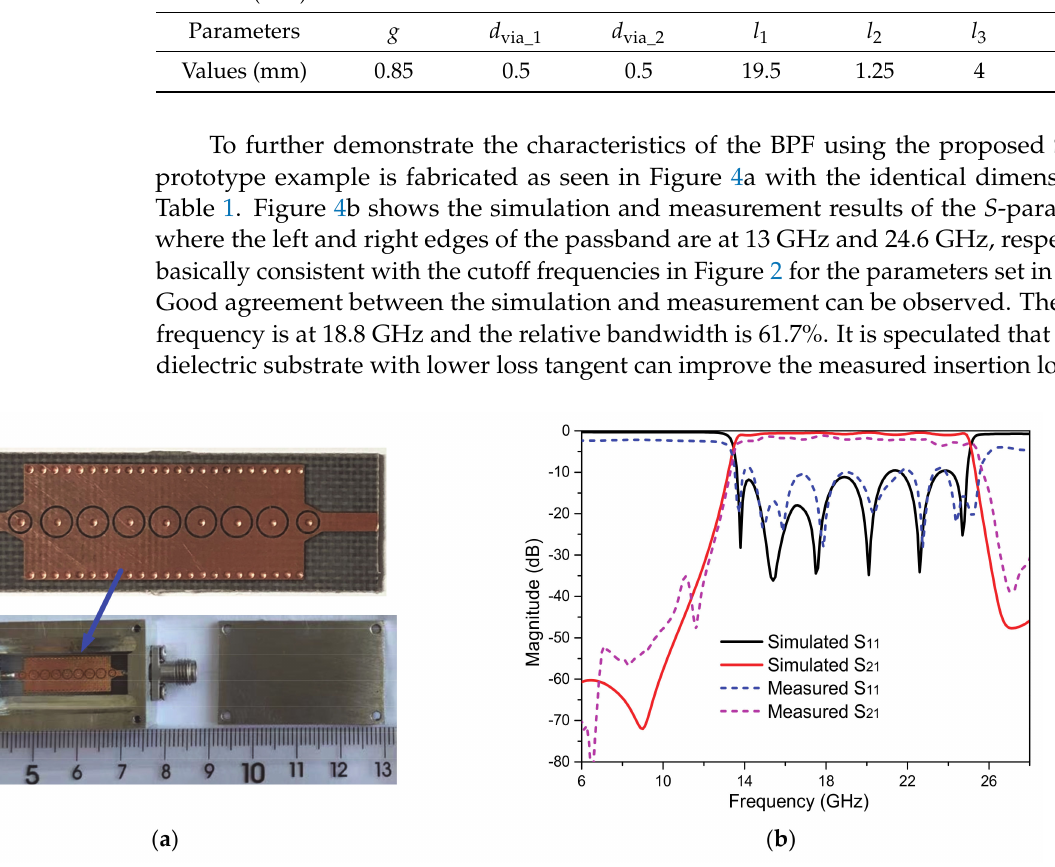
Figure 4. ( a ) Fabricated photograph of the BPF using SSPP and ( b ) the simulation and measurement of the